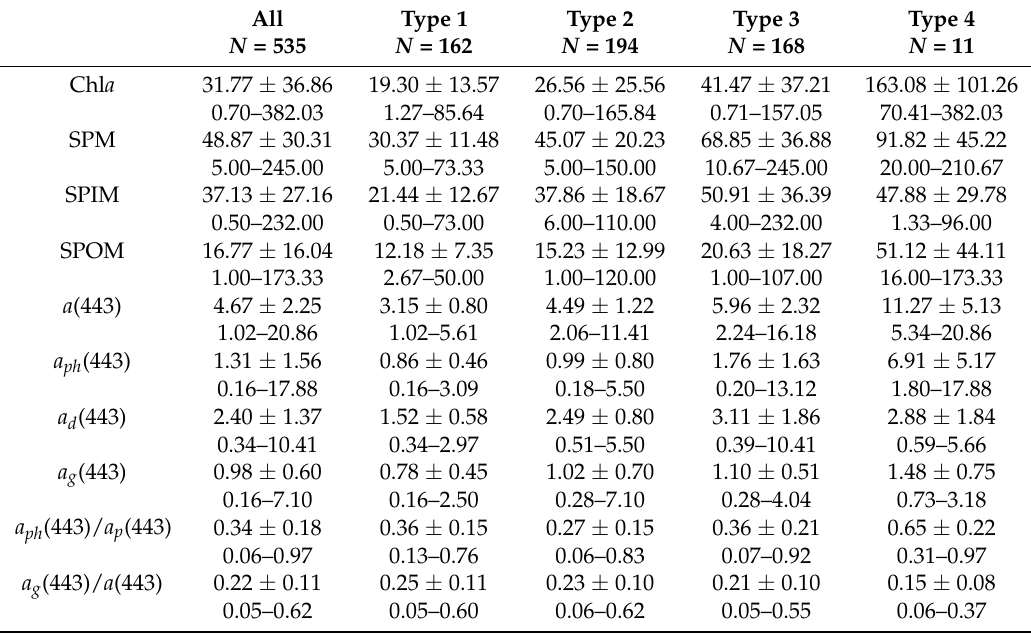
Table 1. The mean value (mean ± SD) and range (min–max) of the field-measured concentrations of chlorophyll- a (Chl a , mg/m 3 ), suspended particulate matter (SPM, SPIM, and SPOM, g/m 3 ), total non-algal particles ( a d (443), m − 1 ), and CDOM ( a g (443), m − 1 ) at 443 nm, a ph (443)/ a p (443) ( a p (443)